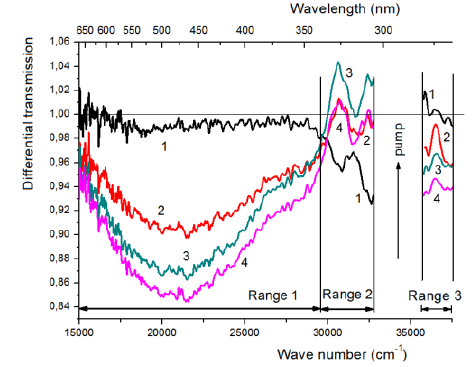
Fig. 2. The spectra of differential transmission of the Ce:LiY x Lu (1-x) F 4 crystal on excitation energy density: 1 – 0,2 J/cm 2 ; 2 – 0,8 J/cm 2 ; 3 – 0,9 J/cm 2 ; 4 – 1,0 J/cm 2